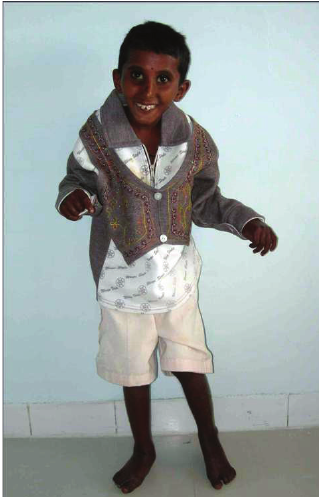
Figure 1: It shows a 9-year-old patient standing in an abnormal gait.